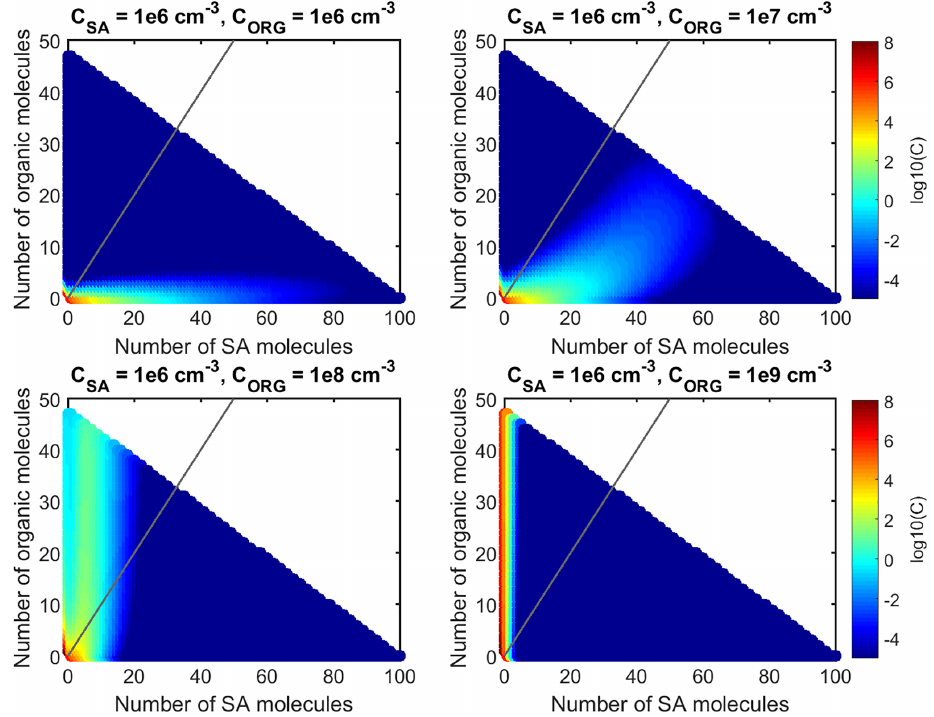
Figure 2. Steady-state cluster distributions in simulations with SA–DMA and LVOC at C SA = 10 6 cm − 3 and C ORG = 10 6 –10 9 cm − 3 . The number of SA molecules and organic molecules in different clusters is shown on the x and y axes, and the color indicates the concentration of a cluster. The gray line shows clusters with 1 : 1